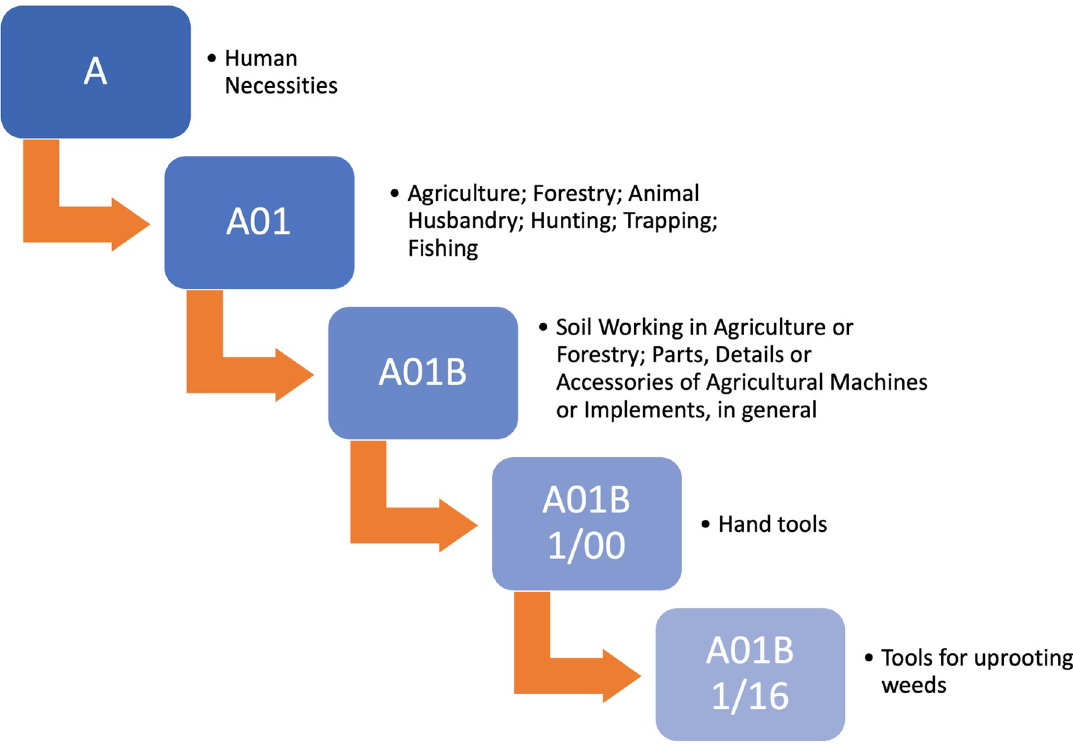
Fig 1. IPC classification example.